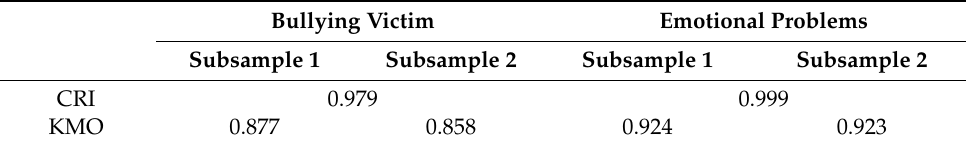
Table 1. Community Ratio Indices and KMO